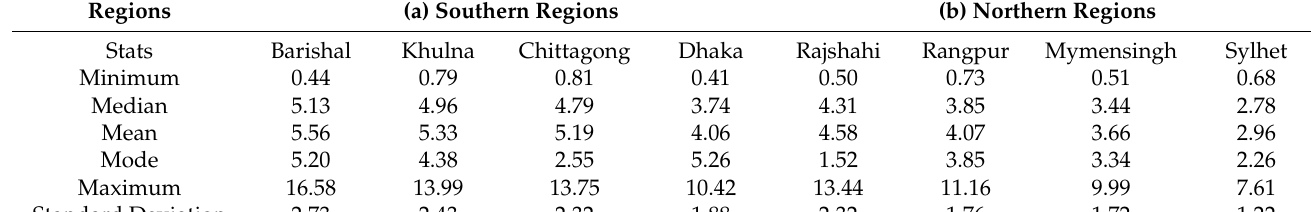
Table 5. For hourly-wind speed (m/s): Descriptive statistics from ERA5 datasets in 2018. Regions